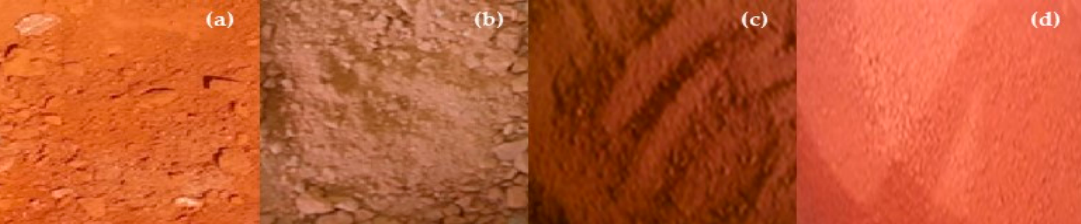
Figure 4. Material after drying, milling and sieving process of red mud ( a ); dried red mud ( b ); comminuted red mud ( c ); and sieved red mud ( d ). comminuted red mud ( c ); and sieved red mud ( d